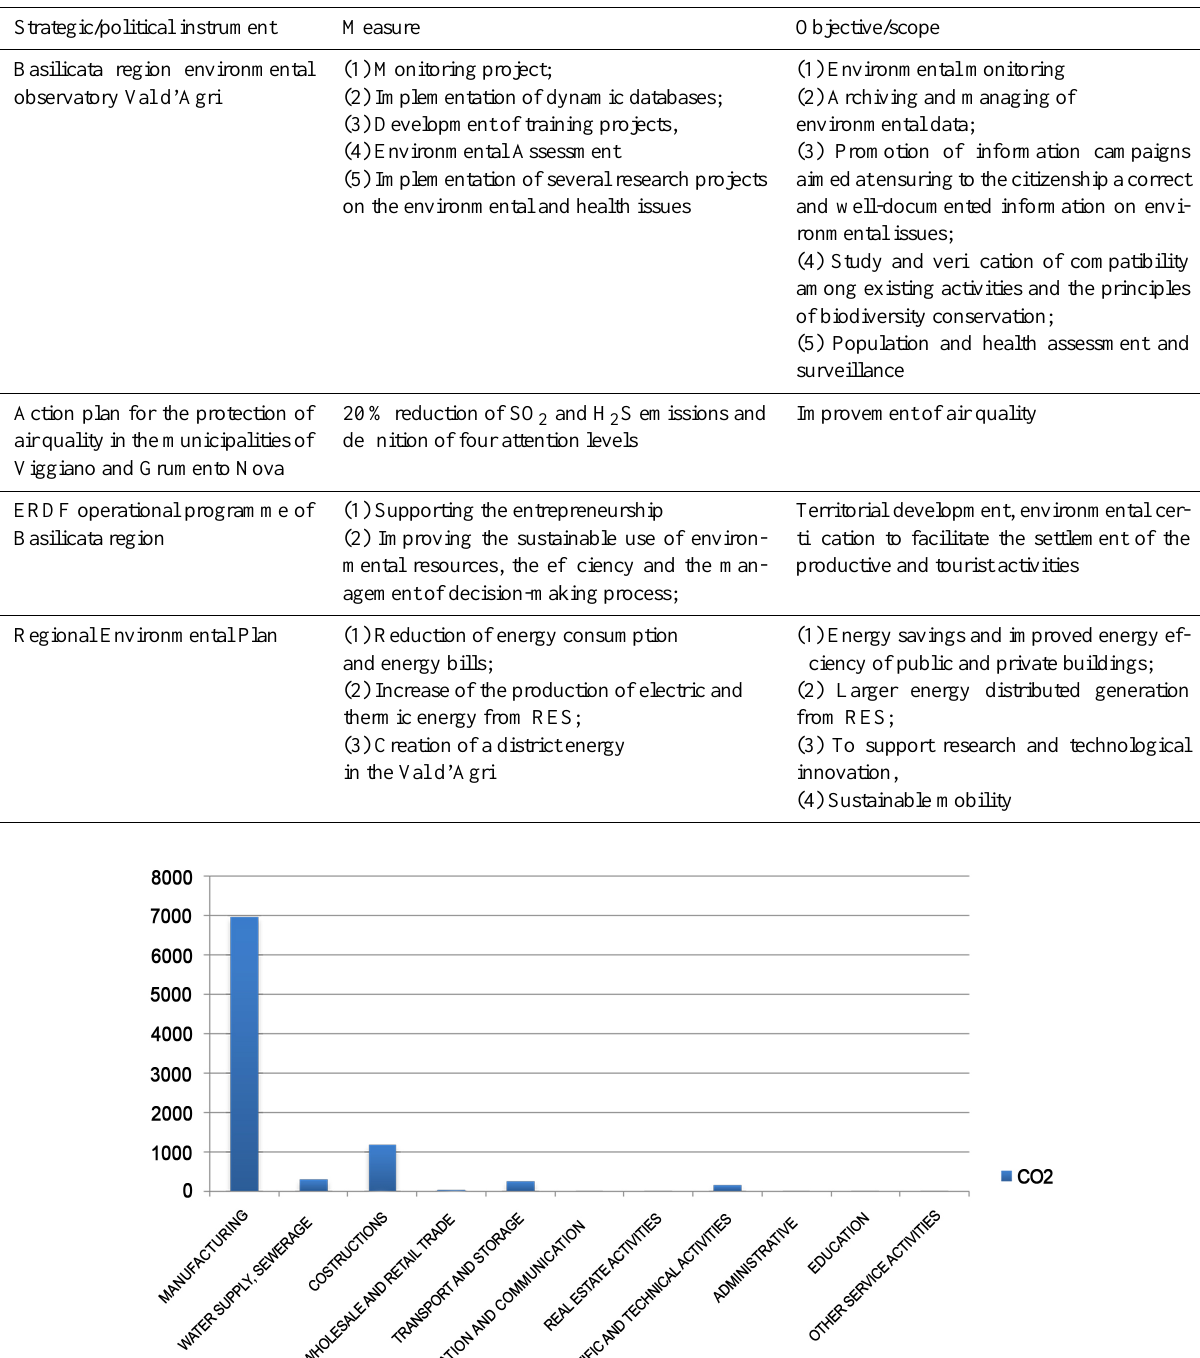
Table 9. Main response indicators selected for the case study.